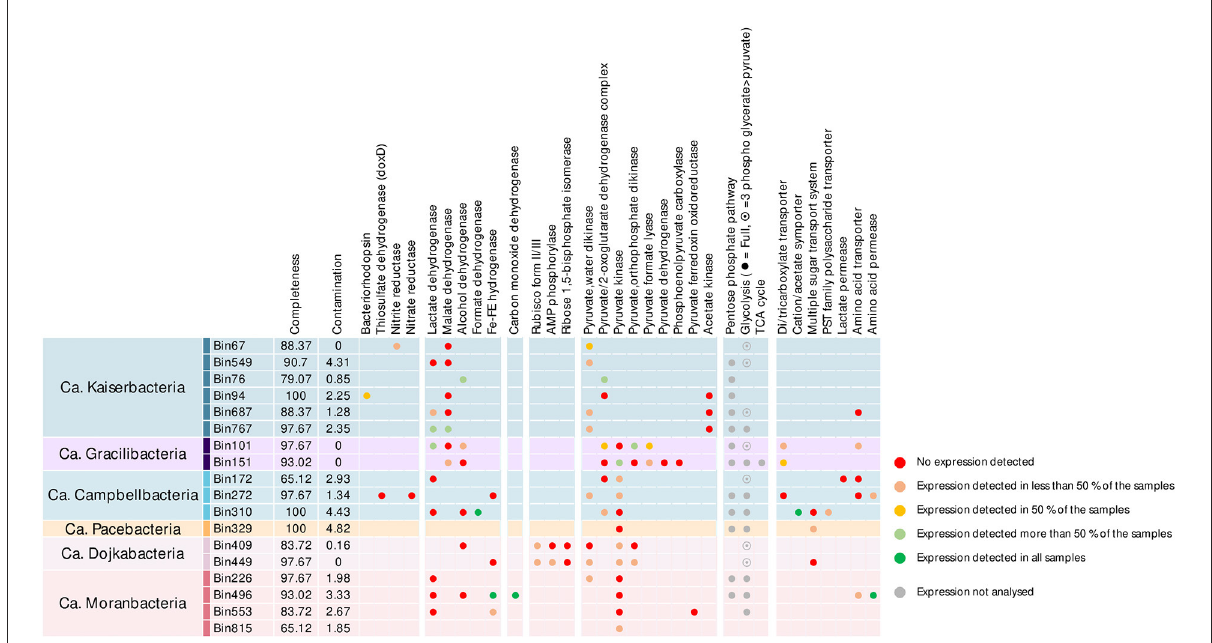
FIGURE3 Metabolic potential and activities identified in the Patescibacteria MAGs of the microbial mats. Completeness and contamination percentages were estimated using CheckM with cpr_43_markers hmm profiles. Dots indicate the detection of the gene in the MAGs and are color-coded based on the identification of corresponding transcripts in the metatranscriptomic dataset. Due to the high number of genes involved, the expression level of complex metabolic pathways (pentose phosphate pathway, glycolysis/neoglucogenesis, and tricarboxylic acid cycle) was not estimated (gray